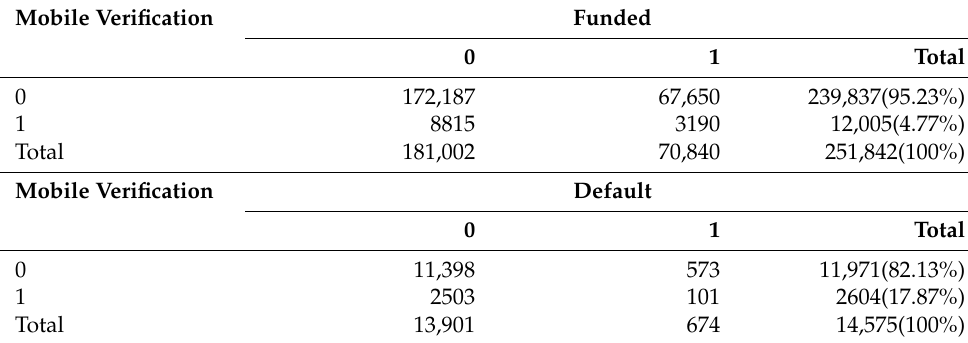
Table 4. Mobile Verification Distribution List.